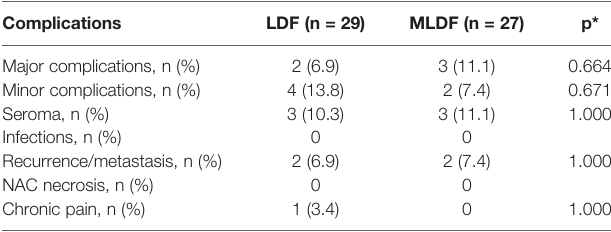
TABLE 3 | Univariate analysis results of the complications between LDF breast reconstruction and MLDF breast